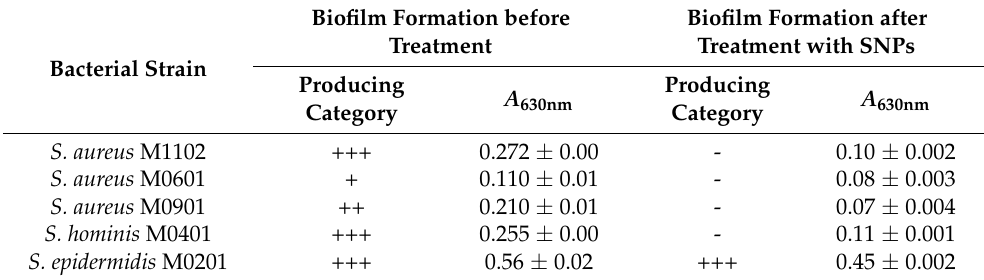
Table 3. Quantitative detection of biofilm formation by Staphylococcus sp. using the MtP assay. Bacterial Strain